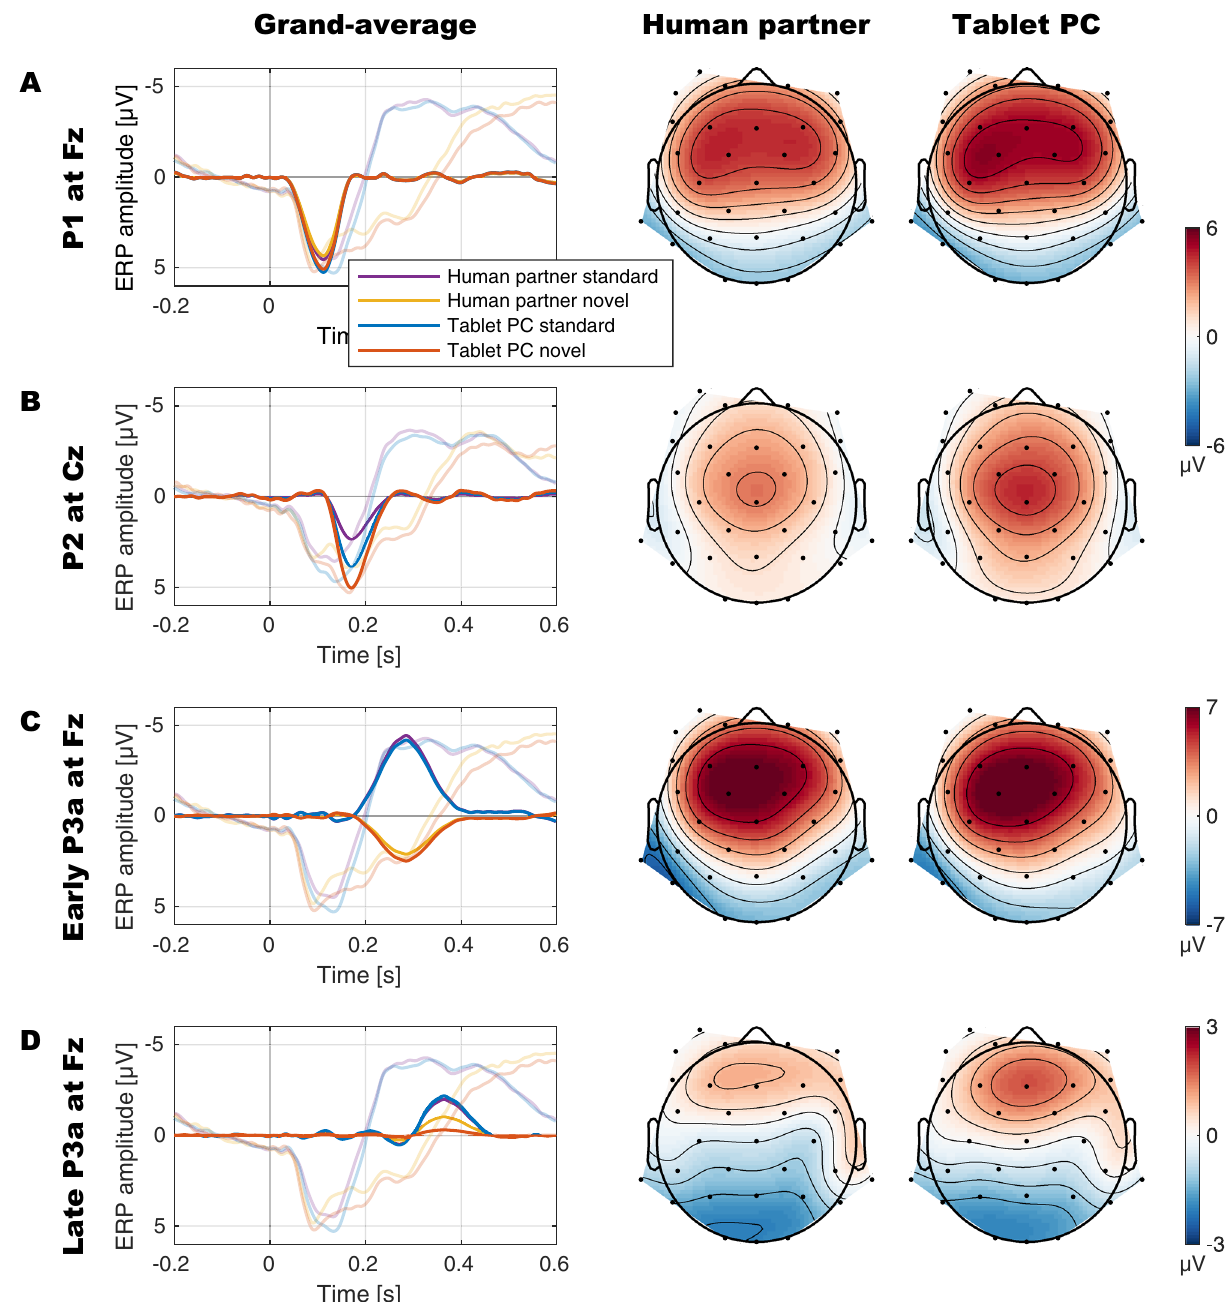
Figure 2. Grand-averages (transparent lines) and component loadings reflecting component time courses (opaque lines) and component topographies of the analyzed PCA components scaled to µV (that is, the portion of the recorded waveform accounted for by each component); ( A ): P1; ( B ): P2; ( C ): early P3a; ( D ): late P3a. The component waveforms are computed as product of component loading times component score times SD per condition averaged across participants (for a proof see Appendix of Dien) 34 . For P1 and P2 components (panels A and B ) the topographies reflect the average of standard and novel trials per condition to illustrate the human partner vs. tablet PC condition main effect. For early and late P3a components, typically defined as difference components (panels C to D ), the topographies reflect the difference of novel minus standard trials to illustrate the condition by stimulus type interaction effect. P1 (panel A ) and P2 (panel B ) components were significantly decreased in the human compared to the tablet PC condition (P2 was also enhanced in response to novel compared to standards; note that the orange waveform representing the tablet PC novel—overlaps with the blue waveform representing the human standard in panel B). The early P3a (in the novel minus standard difference waveform) was observed in both conditions, but its amplitude was not modulated by condition ( C ). The late P3a was also observed in both conditions and was decreased in the human condition compared to the tablet PC condition ( D